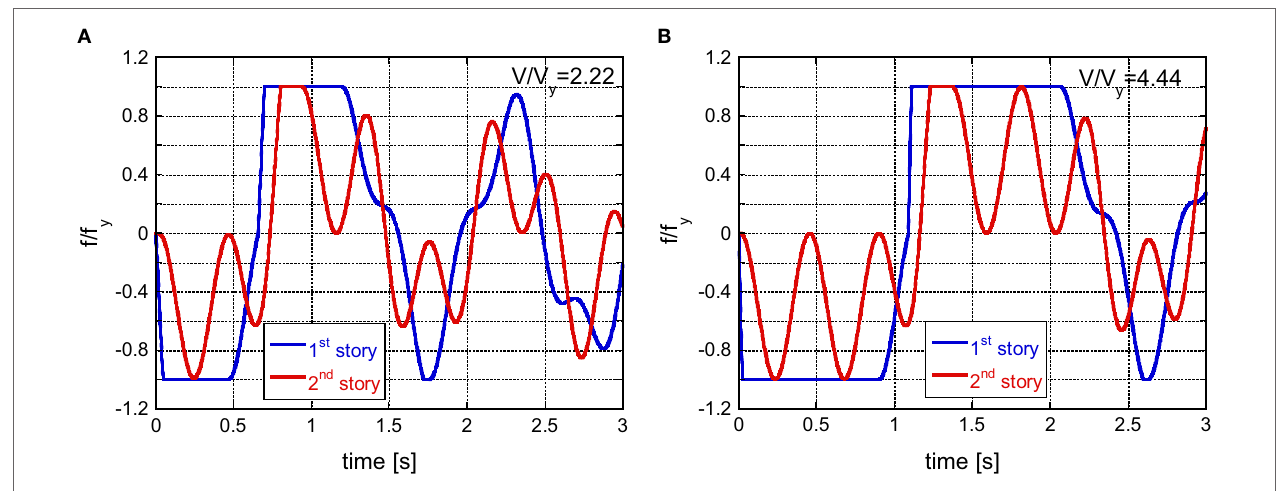
FigUre 18 | Time histories of the restoring forces in the first and second stories for the same 2DOF model subjected to the double impulse with V / V y = 2.22, 4.44 . (a) V / V y = 2.22 ( t 0 c = 0.658 [s]). (B) V / V y = 4.44 ( t 0 c = 1.089 [s]).